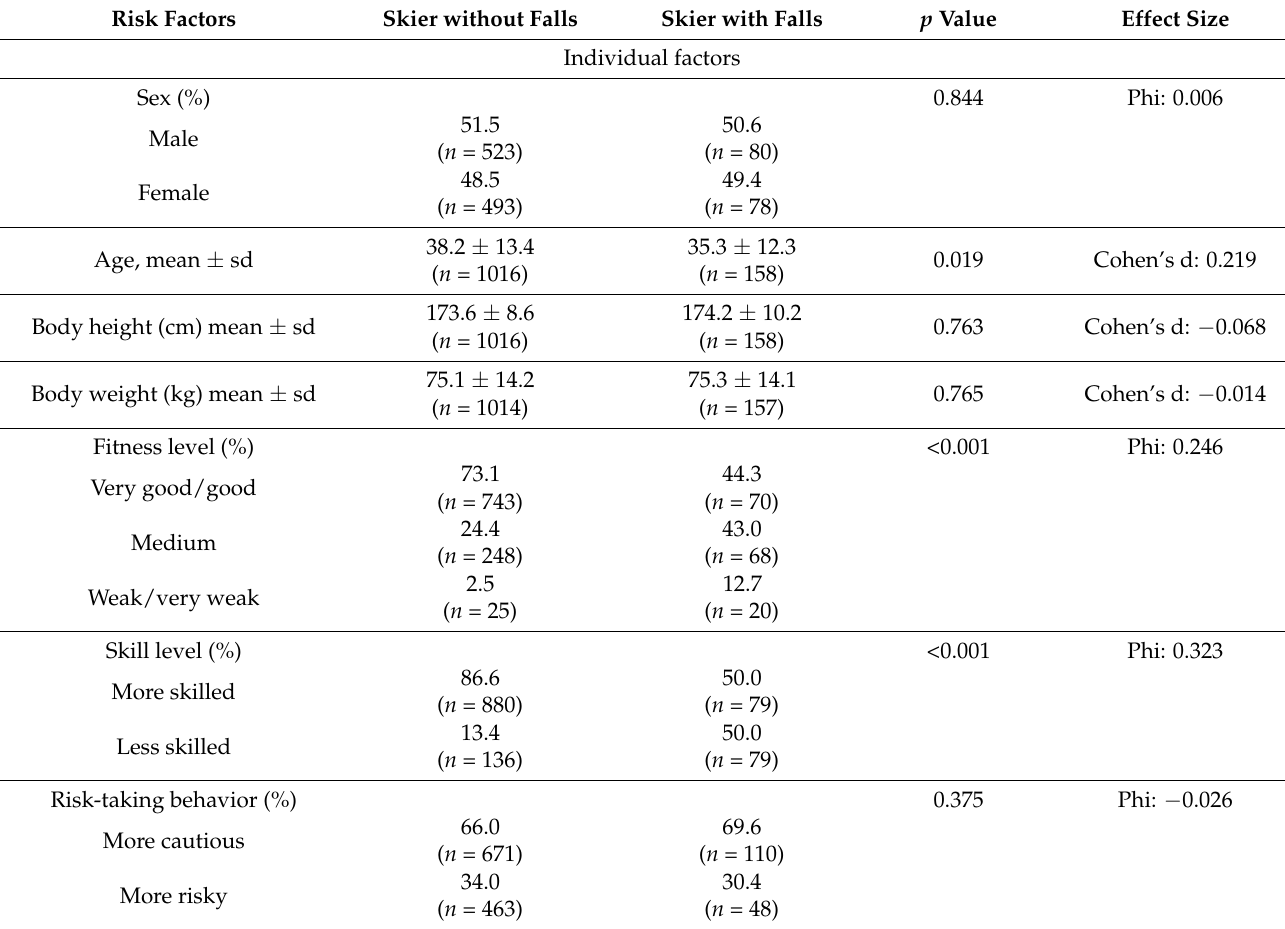
Table 1. Univariate comparisons of individual, equipment-related and environmental factors between recreational skiers without and with